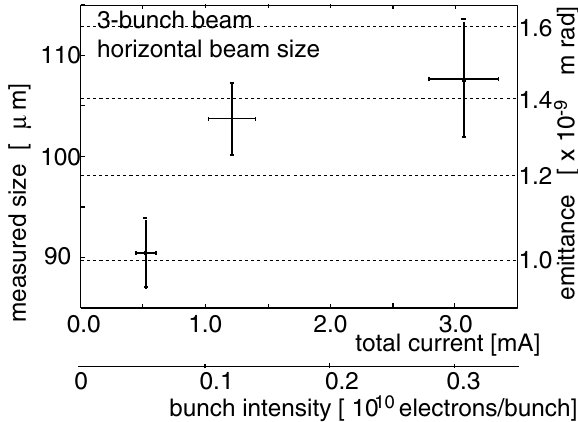
FIG. 12. Vertical emittance of the 3-bunch beam vs the elec- tron current.